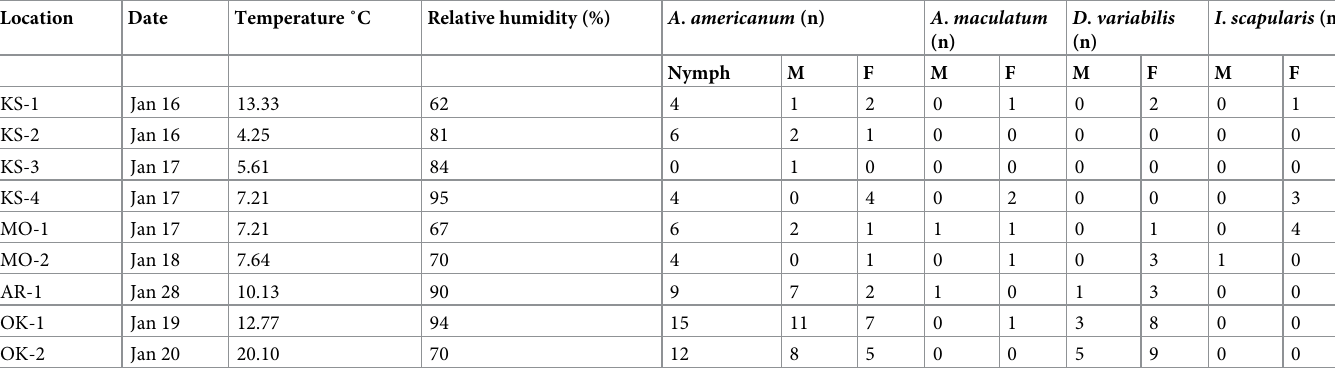
and 3, S1 Table ) . The number of ticks collected from each location was variable among sites of different land- cover characteristics (Fig 4). Sites with predominantly forest/woodland land cover and Table 2. Number of ticks caught in different locations during January 16 –January 20, 2017 and the ambient temperature and relative humidity. Location